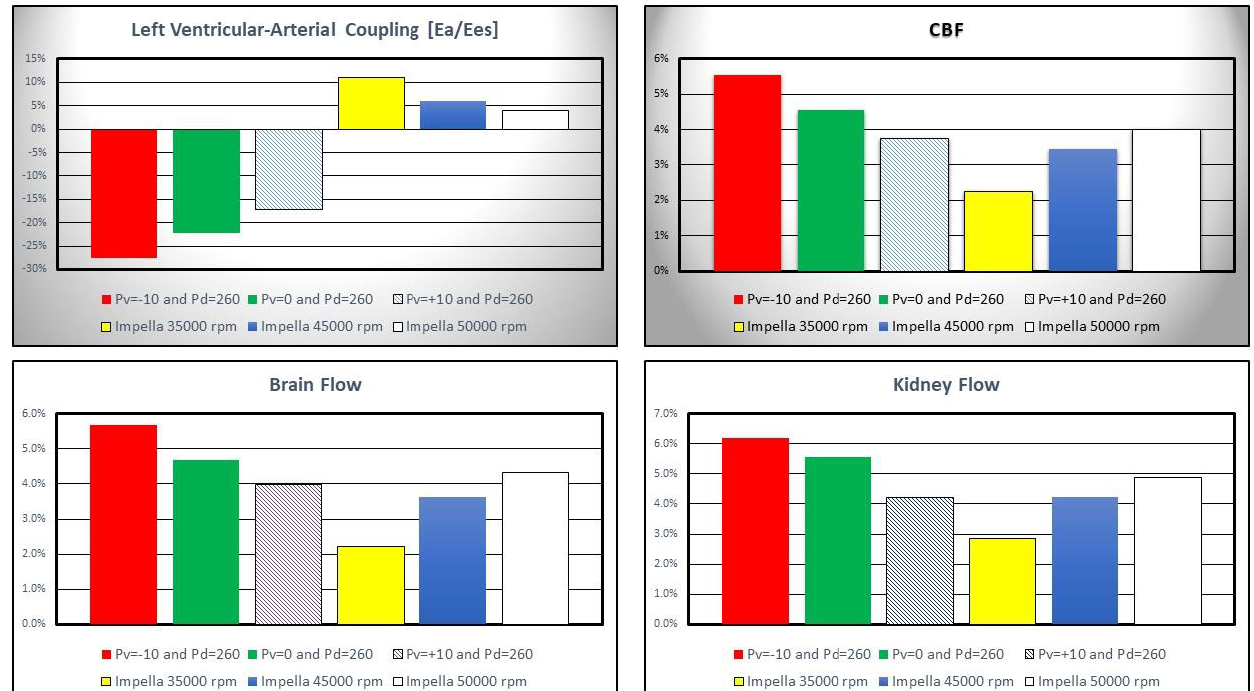
Figure 7. Percentage change calculated in comparison to baseline conditions for left ventricular- arterial coupling, coronary, cerebral and renal blood flow when IABP or LVAD support were sim- ulated. The simulation settings included Impella 2.5 rotational speed at 35,000, 45,000 and 50,000 rpm and IABP support with Pv = − 10, Pv = 0 and Pv = +10 mmHg, and Pd = 260 mmHg. E a is the arterial elastance and E es is the left ventricular elastance.